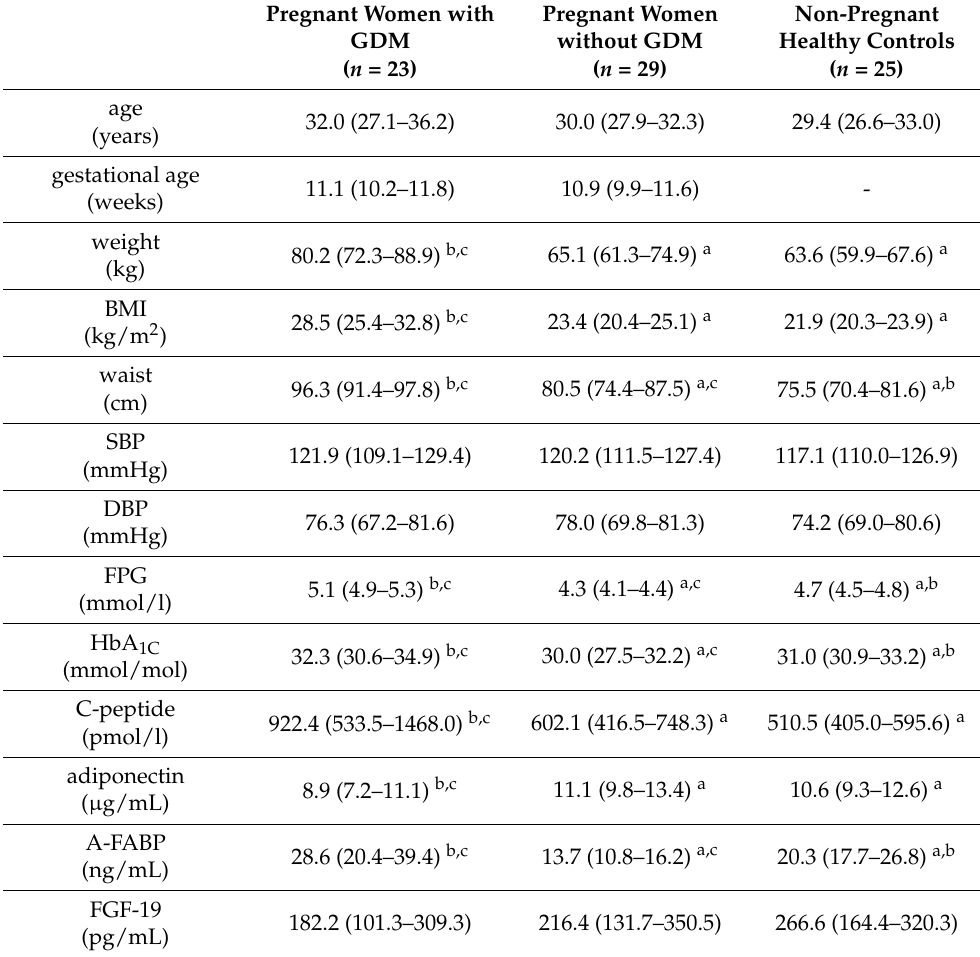
Table 1. Baseline clinical and laboratory parameters in individual